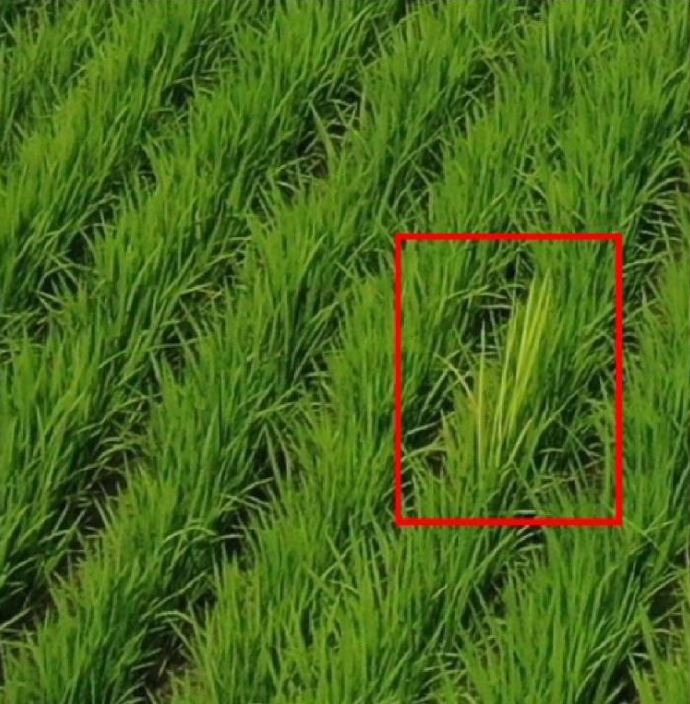
Figure 2. The rice infected with Bakanae disease photographed from above (Red box corresponds to RBD-infected bunch).